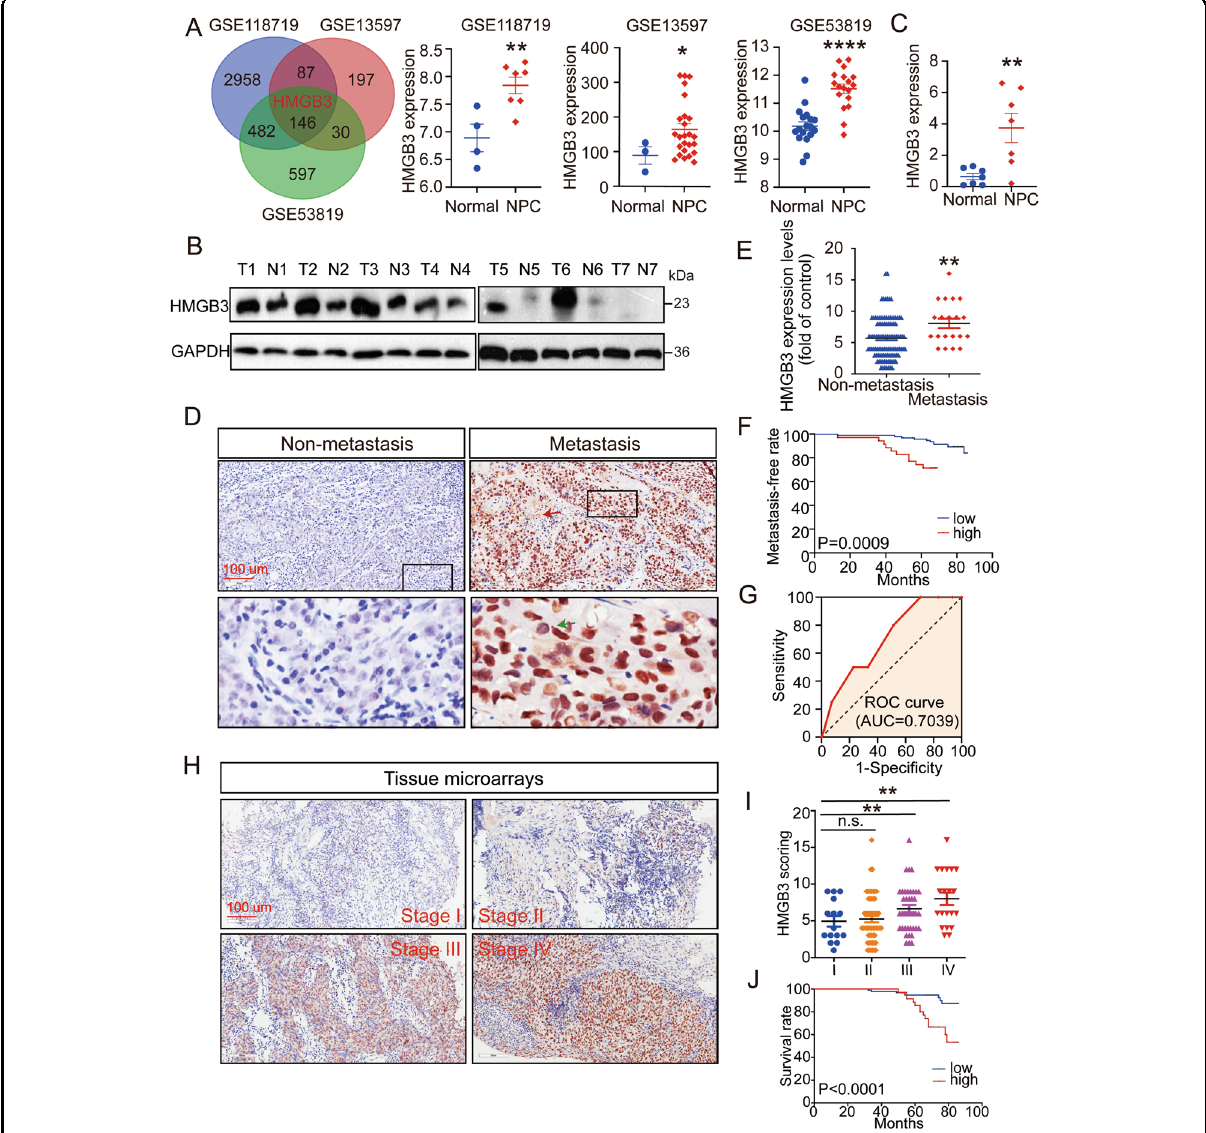
Fig. 1 Overexpression of HMGB3 is related to clinical outcomes of NPC patients. A A Venn diagram of all upregulated genes among three GEO databases (GSE118719, GSE13597 and GSE53819) and the expression of HMGB3 in them. B HMGB3 protein levels in NPC tissues ( n = 7) and normal nasopharyngeal epithelial tissue ( n = 7) were examined by western blot. GD(GAPDH) was used as a loading control. C HMGB3 mRNA levels in NPC tissues ( n = 7) and normal nasopharyngeal epithelial tissue ( n = 7) were examined by qRT-PCR. D Representative IHC images of HMGB3 staining from NPC patients with or without metastasis and the black boxes indicate regions of pictures shown in the bottom two pictures. E Statistical comparison of HMGB3 score in the two groups. F The HMGB3 score was de fi ned as low expression (1 – 8 points)( n = 94) and high expression (9 – 16 points)( n = 35). And the Kaplan – Meier analysis in the relationship between HMGB3 expression and metastasis of NPC. G The receiver operating characteristic (ROC) curve was plotted to validate the predictive accuracy of HMGB3 expression in metastasis NPC (ROC AUC = 0.7039). H Representative IHC images of HMGB3 staining in four TNM stages. I Statistical comparison of HMGB3 score in the four groups. J Kapla – Meier survival analysis of NPC patients ’ overall survival by X-tile Software. The scale bar in 200× images represents 100 µm. Mean ± SD, * P < 0.05, ** P < 0.01, *** P < 0.001, **** P < 0.0001, student ’ s